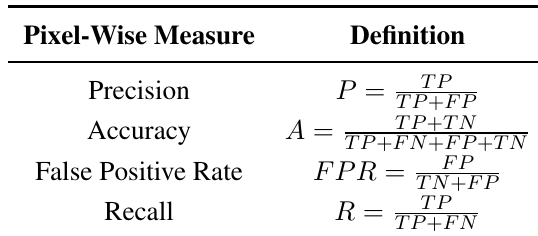
Table 2. Performance metric.